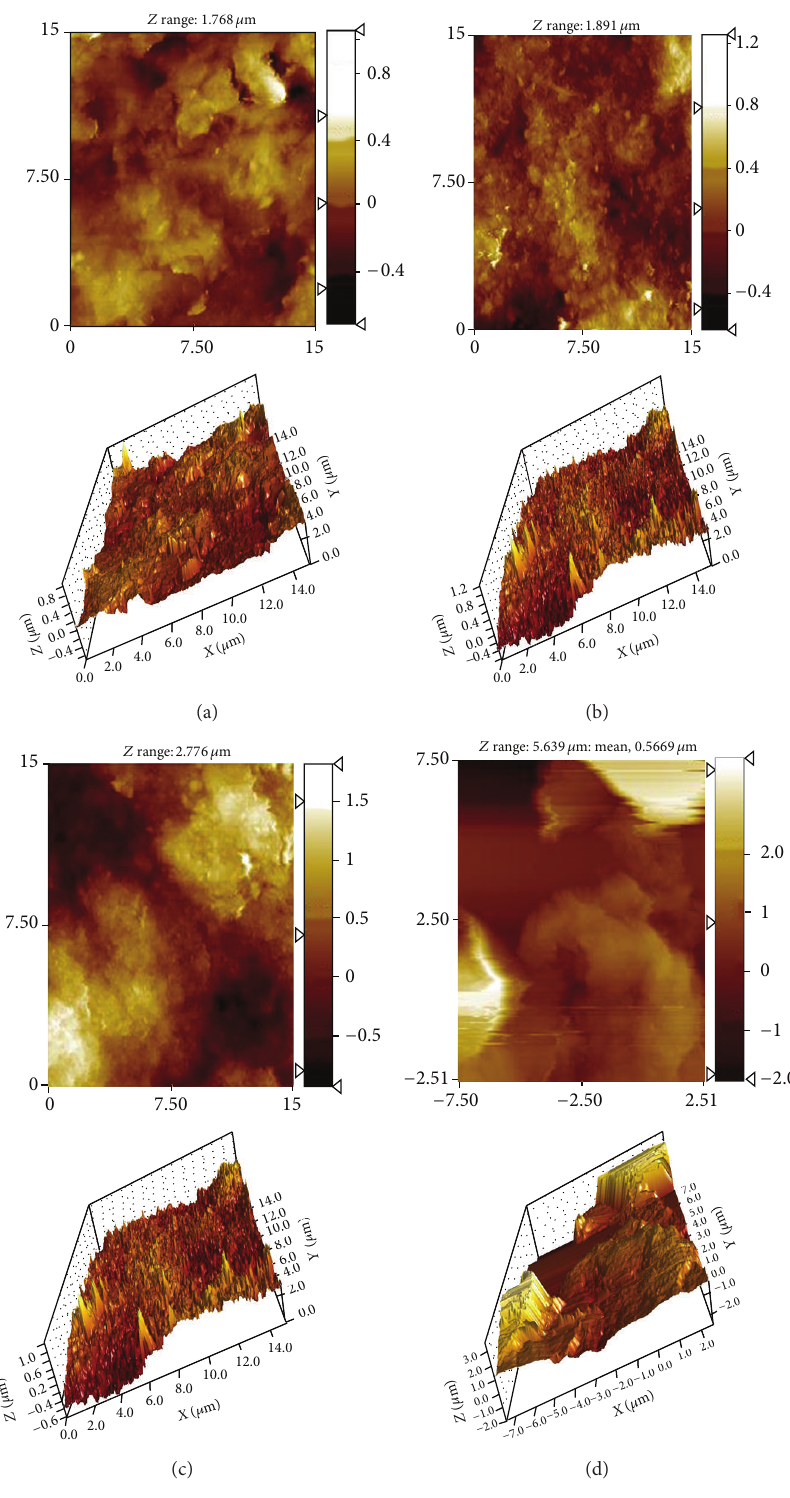
Figure 6: AFM-3D images of the screen-printed electrode (a), MWNT-modified electrode (b), COOH/MWNT-modified electrode (c), and AChE-ChOx/COOH/MWNT-modified electrode